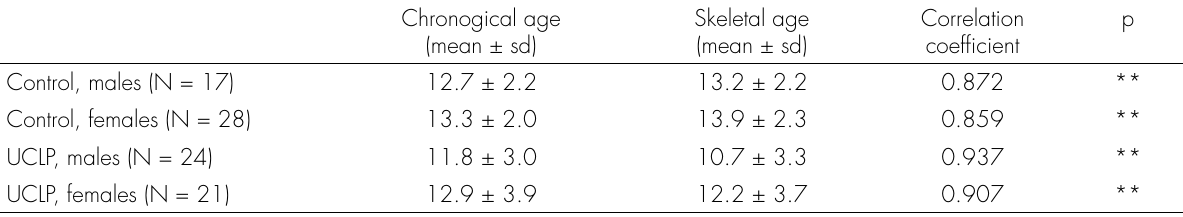
Figure 3. Skeletal and chronological age curves of the study groups. Table II. Correlation coefficients for the chronological and skeletal ages in UCLP and control